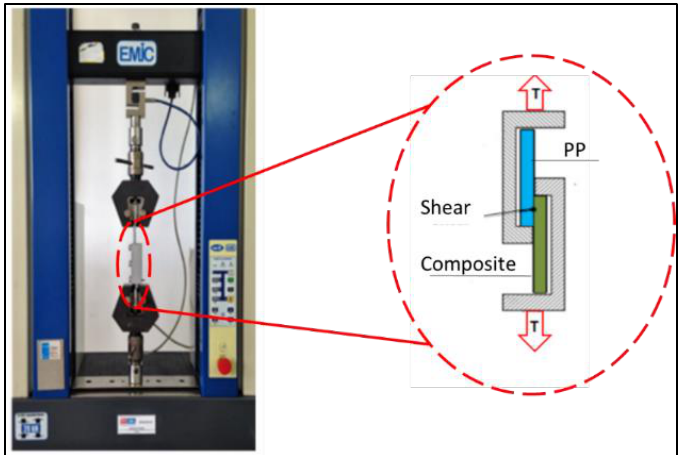
Figure 4. Schematic of the shear stress adapted to a universal testing machine. Table 2. Factor levels for the design of the polypropylene (PP)/composite factorial